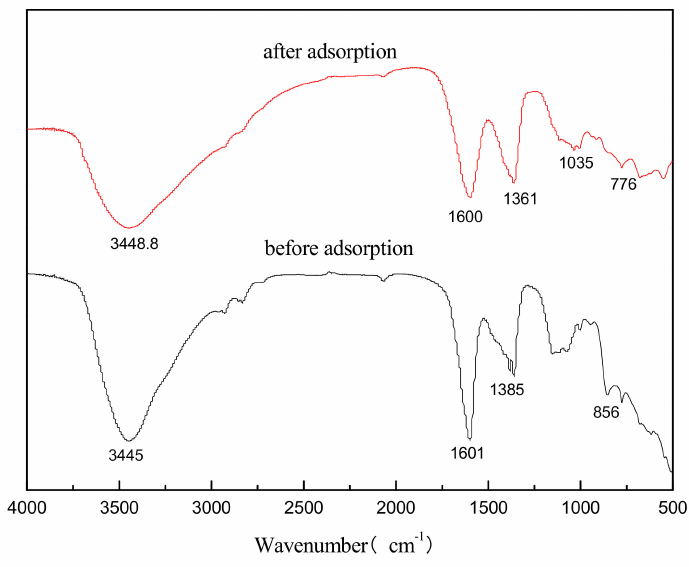
Figure 6. FTIR spectra of Mg-Al metal oxides before and after